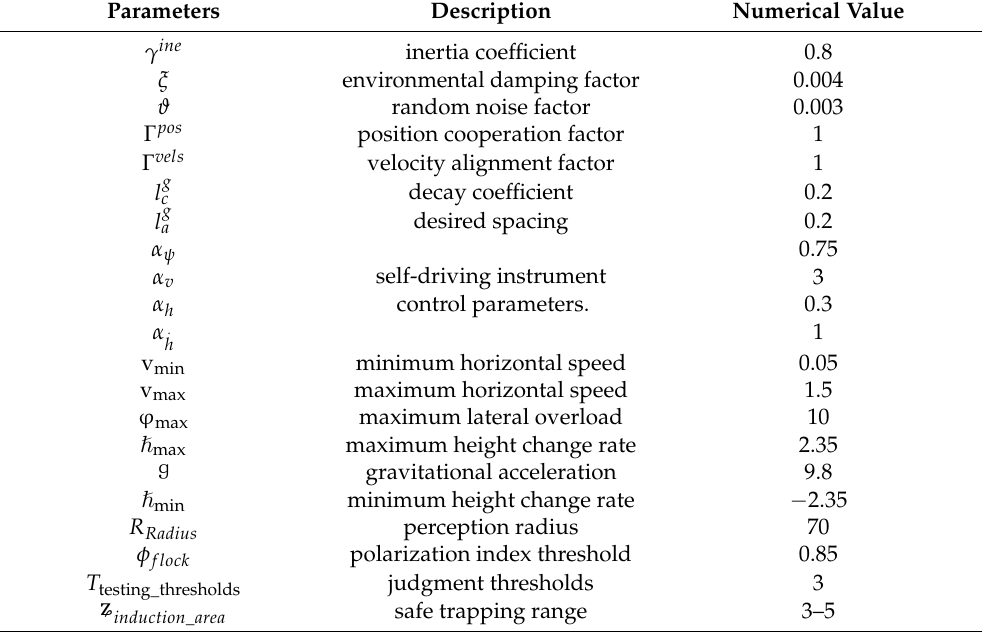
Algorithm 2 Sub-Swarm Trapping